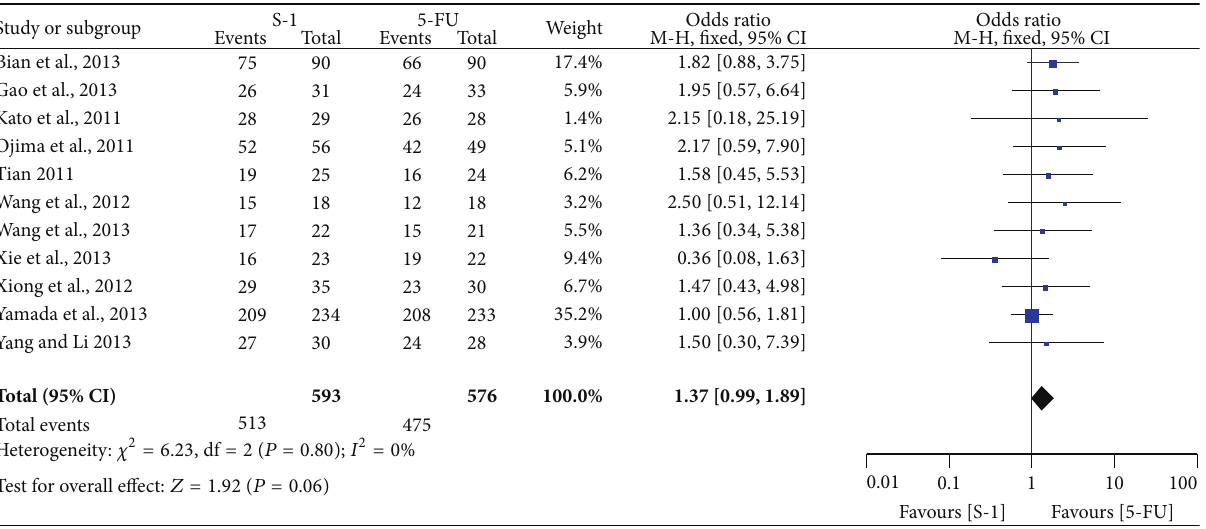
Figure 8: Forest plot of odds ratio of disease control